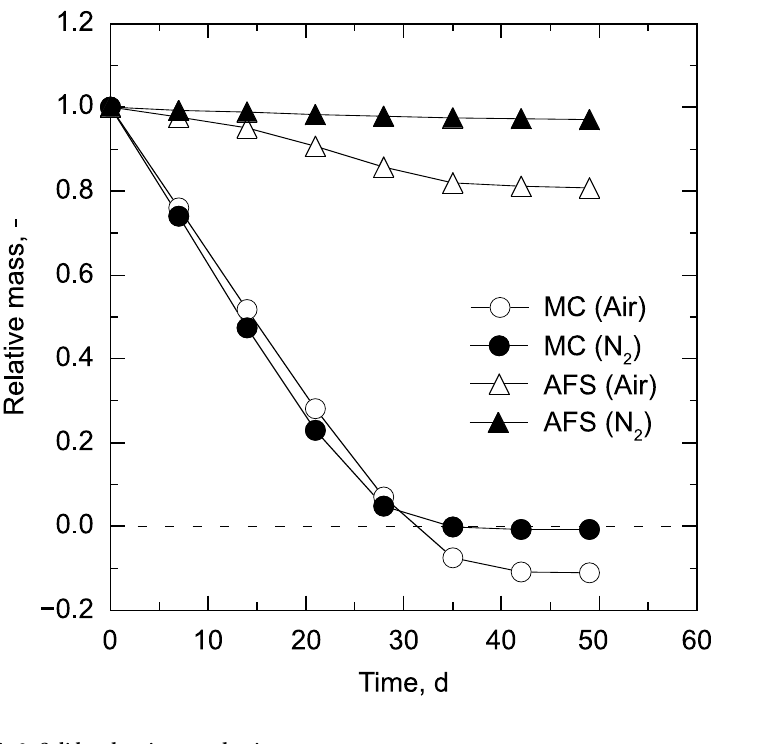
Fig 3. Solid and moisture reduction curves.